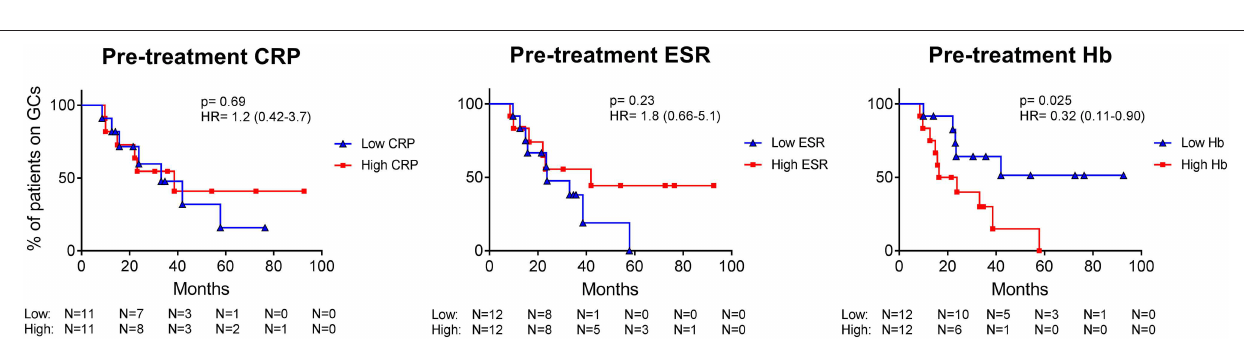
FIGURE 7 | In PMR patients, long-term GC requirement is predicted by pre-treatment Hb levels, but not by CRP and ESR. The CRP, ESR, and Hb of PMR patients before treatment were split into low or high levels (based on the median) and were plotted in a Kaplan-Meier curve against time to GC-free remission. p -value and hazard ratio (HR; including 95% confidence interval) of the log rank test are depicted in the